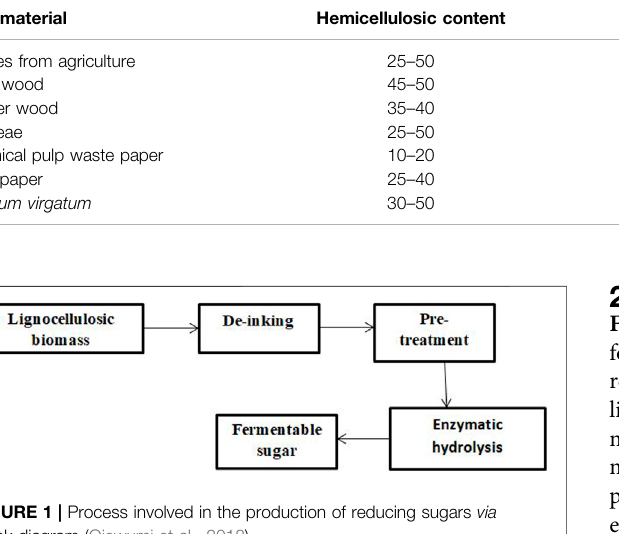
Frontiers in Chemical Engineering |